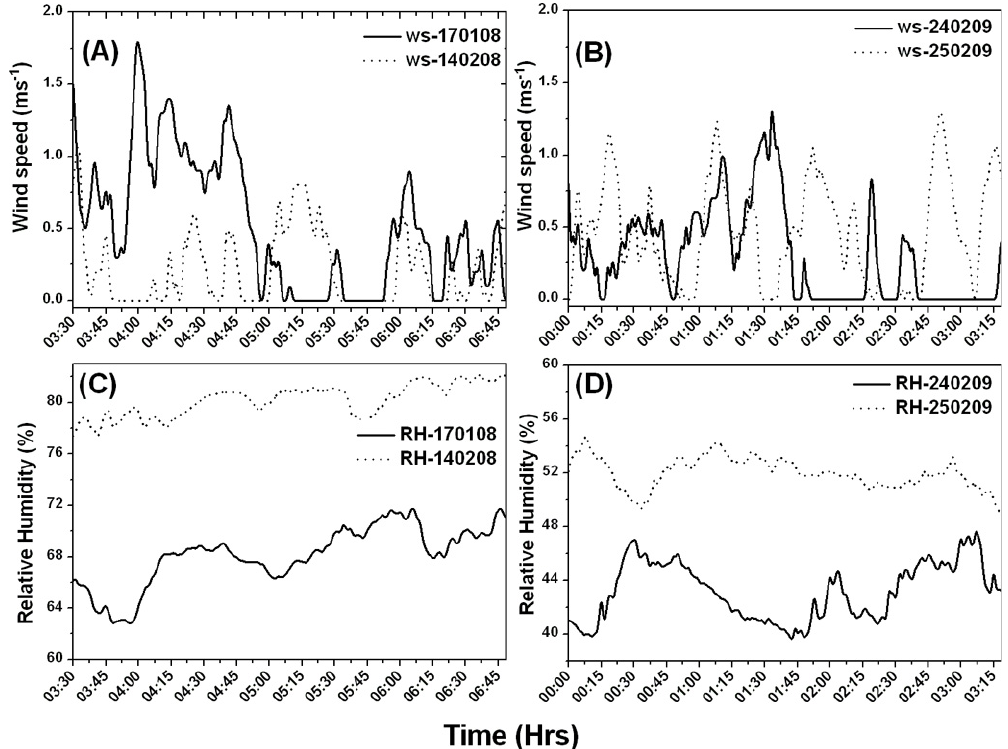
Fig. 2. The time variation of surface wind speed in ms − 1 on: (A) 17 January and 14 February 2008; (B) 24 February and 25 February 2009. (C) and (D) are, respectively, for (A) and (B) but for surface relative humidity (%).